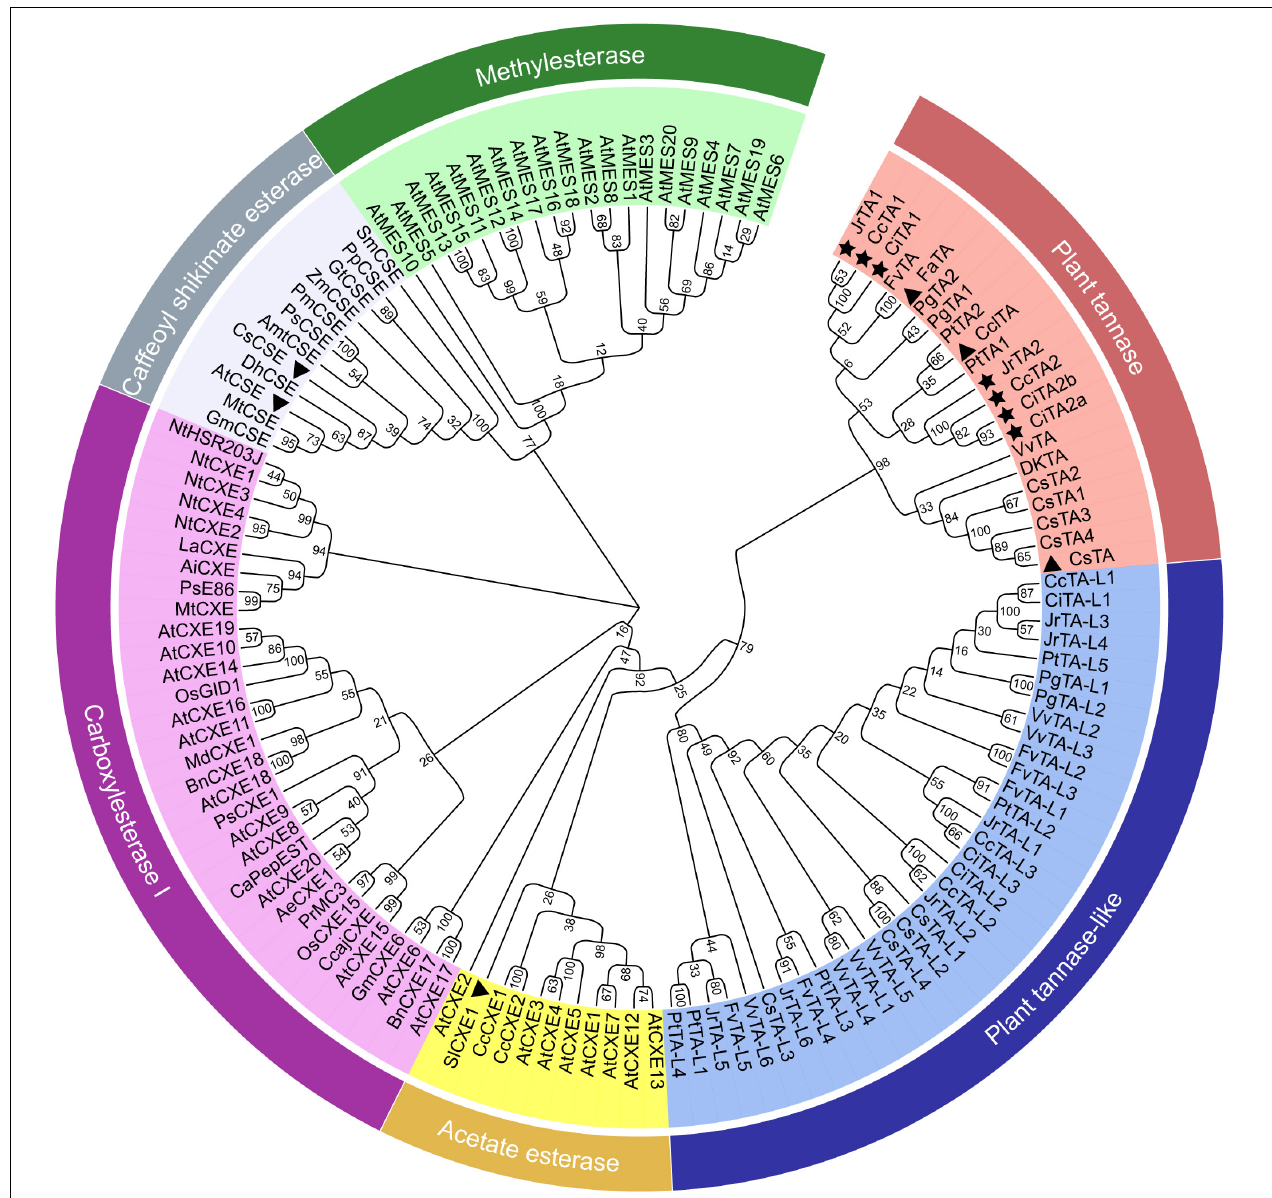
FIGURE 2 | Molecular phylogenetic analysis of gene families among plant tannase genes and other carboxylesterase genes. The evolutionary history was inferred using the Neighbor-Joining method. The bootstrap consensus tree inferred from 1000 replicates was used to represent the evolutionary history of the tannase genes. Whole tree was divided into five clades, plant tannase clade (with red range), plant tannase-like clade (with blue range), acetate esterase clade (with yellow range), carboxylesterse I clade (with orchid range), caffeoyl shikimate esterase clade (with gray range), and methylesterase clade (with green clade). Previous reported tannase and carboxylesterase genes were marked with a triangle. The Juglandaceae tannase genes in walnut, pecan, and Chinese hickory were marked with